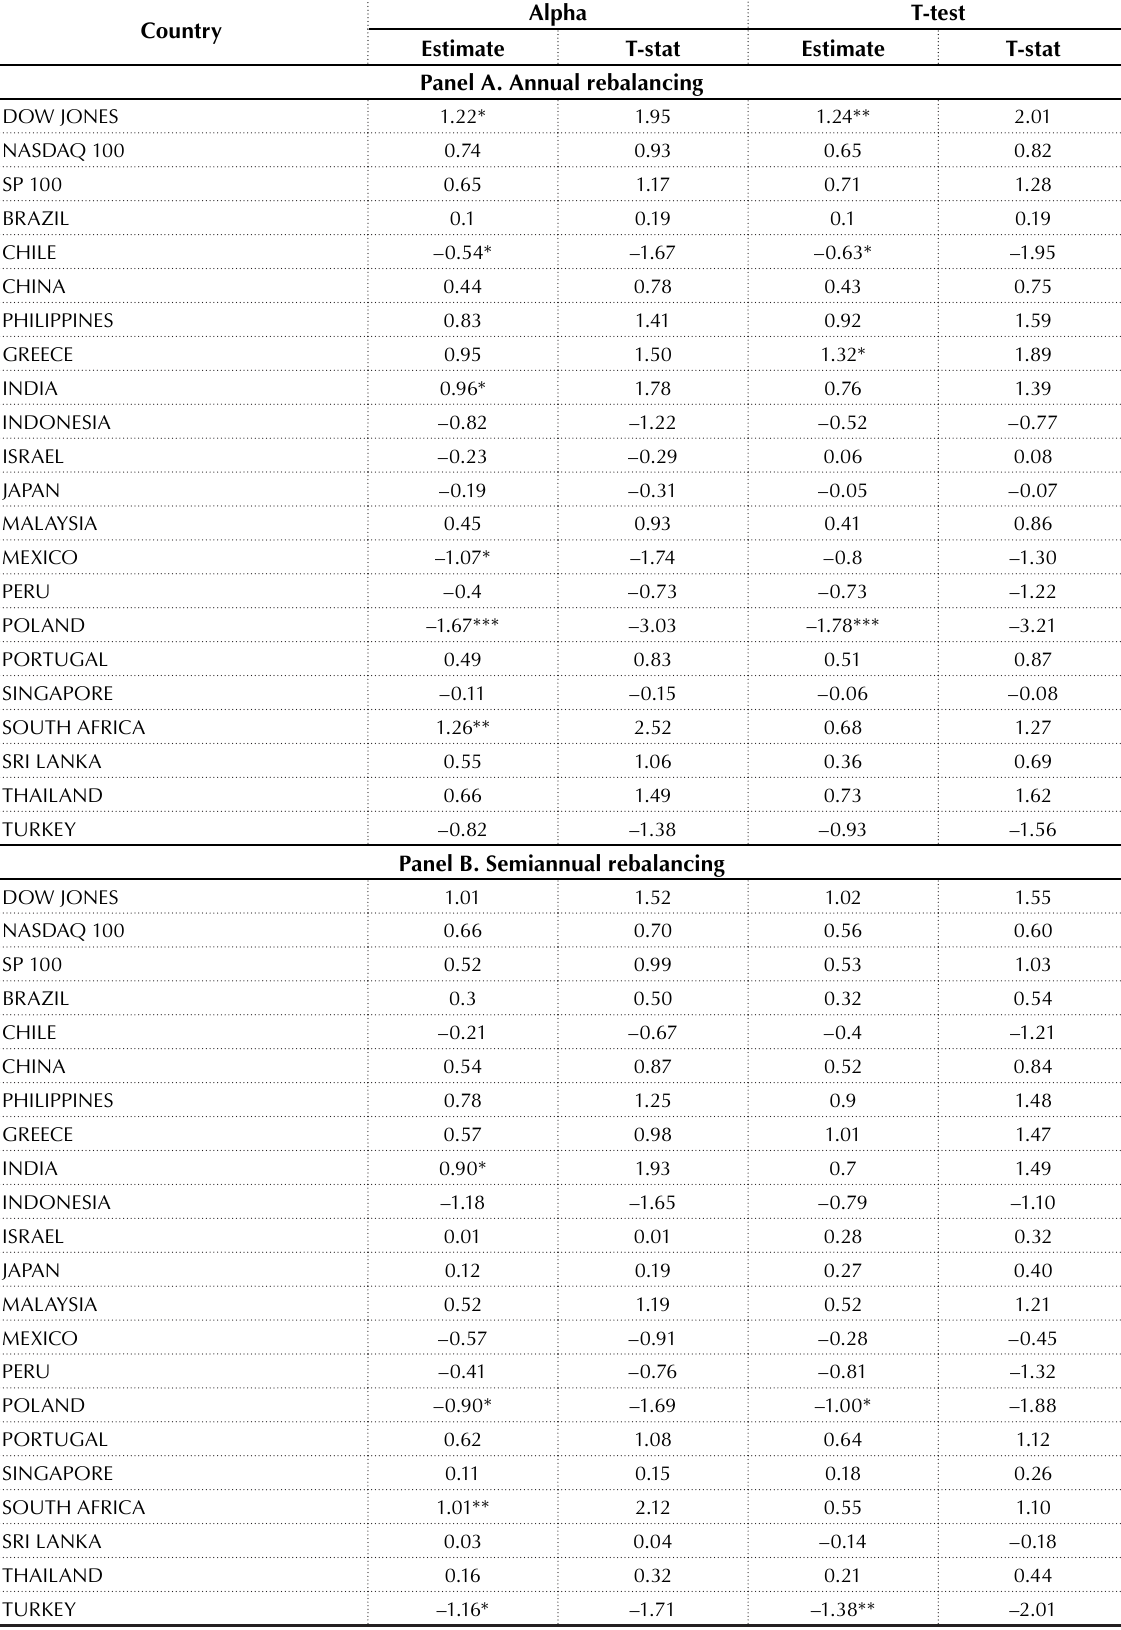
Table 3. Statistical tests of performance of mean-variance optimized portfolios